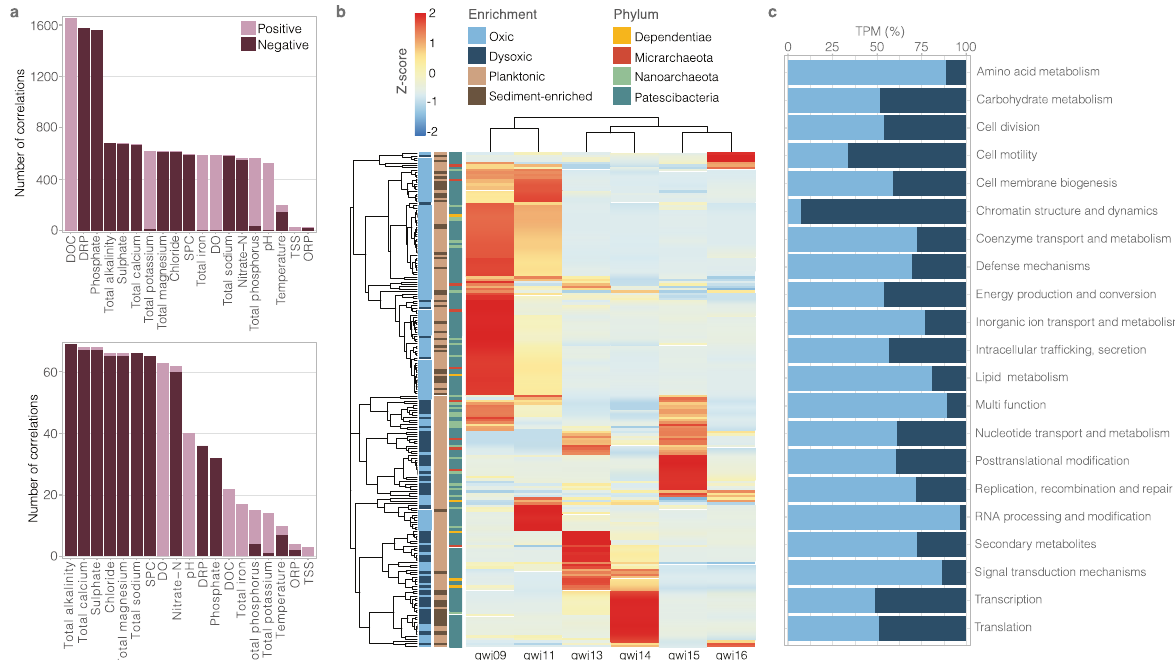
Fig. 5 Ultra-small transcriptional pro fi les across samples and relationship to groundwater physicochemical parameters. a Number of signi fi cant Pearson correlations between modi fi ed-TPM values and groundwater parameters at gene (top) and genome (bottom) levels ( p < 0.05). Pearson correlation coef fi cients range from 0.81 to 0.99 and − 0.99 to − 0.81 for both gene level and species level correlations. b Heatmap showing total modi fi ed-TPM per MAG across six groundwater metatranscriptomes. modi fi ed-TPM values were scaled to row and column ( Z -score). c Distribution of ultra-small prokaryote modi fi ed-TPM across EggNOG metabolic categories in oxic and dysoxic groundwater samples. Proportions were based on average total modi fi ed-TPM per metabolic category across oxic vs. dysoxic